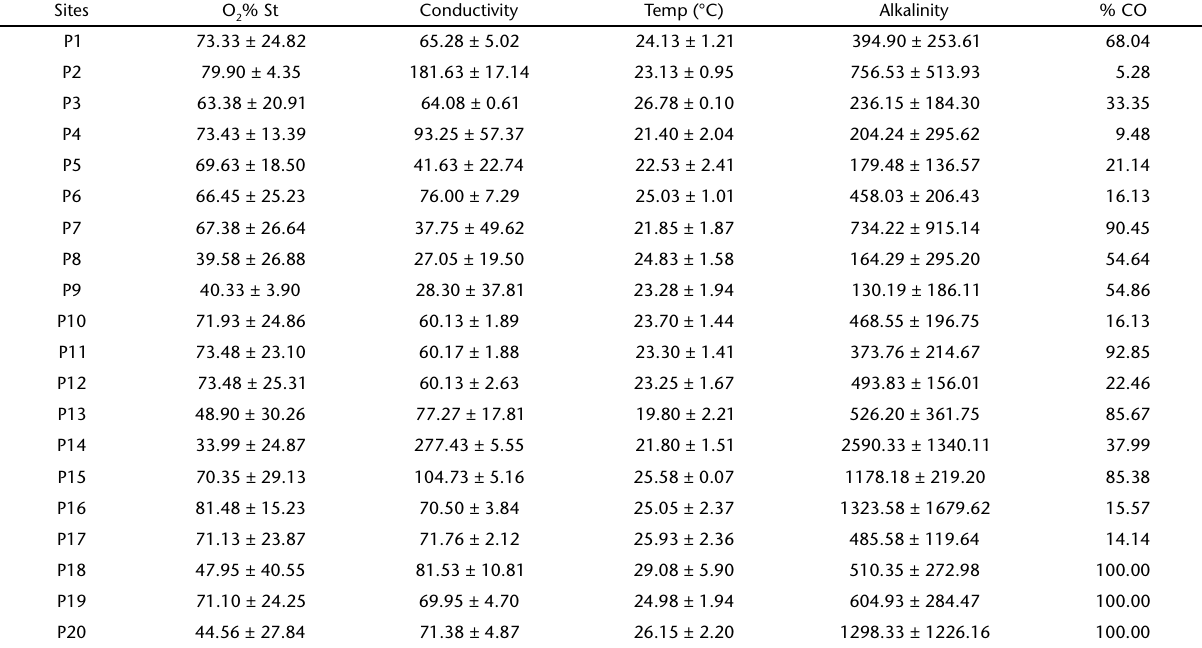
Table III. Average values and the standard deviation of the percentage of dissolved oxygen in the water (O water temperature (Temp), alkalinity (µEq/L), and the percentage of canopy openness (% CO) in 20 sites along the Pandeiros River Basin.